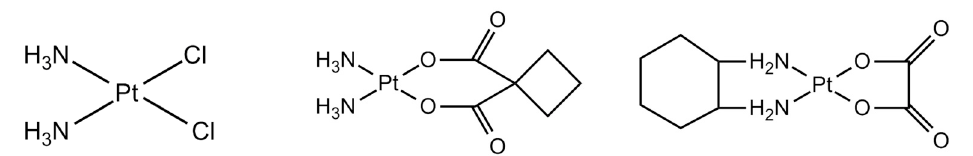
Figure 1. Chemical structures of the clinically approved platinum-based anticancer drugs cisplatin, carboplatin, and oxaliplatin.